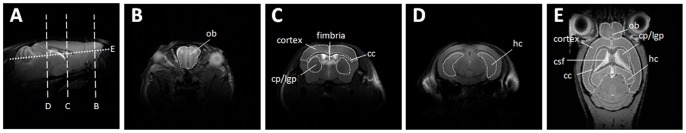
Examples on region-of-interest (ROI) delineating different anatomical regions.T2-weighted spin echo images of the mouse brain acquired at 9.4T in sagittal (A), axial (B–D) and horizontal (E) orientation. ROIs were identified for the olfactory bulb (ob), cerebral cortex (cortex), caudate putamen and lateral globus pallidus (cp/lgp), hippocampus (hc), corpus callosum (cc), fimbria hippocampi (fimbria) and ventricles (csf).